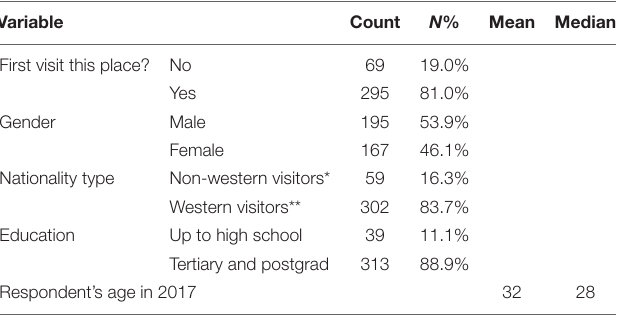
TABLE 5 | Basic demography of survey respondents (total tourists n =